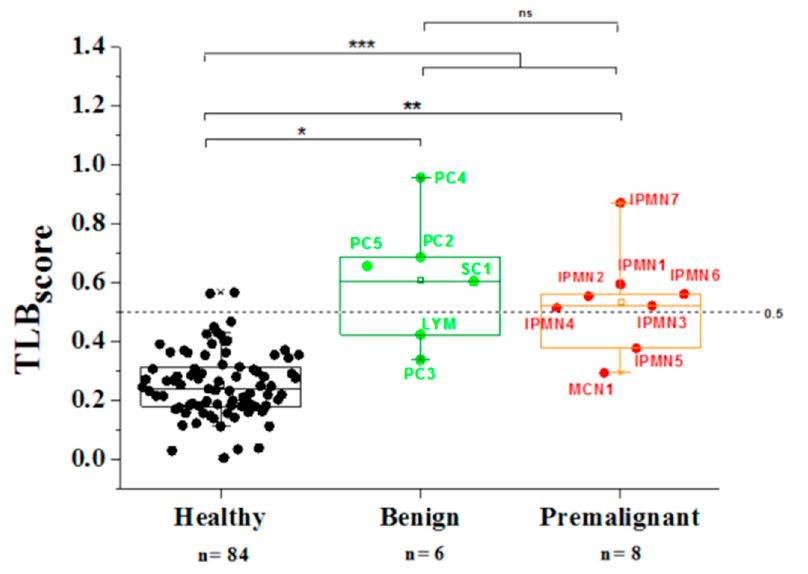
Figure 6. TLB serum score from serum TLB profiles from healthy controls and both types of cysts